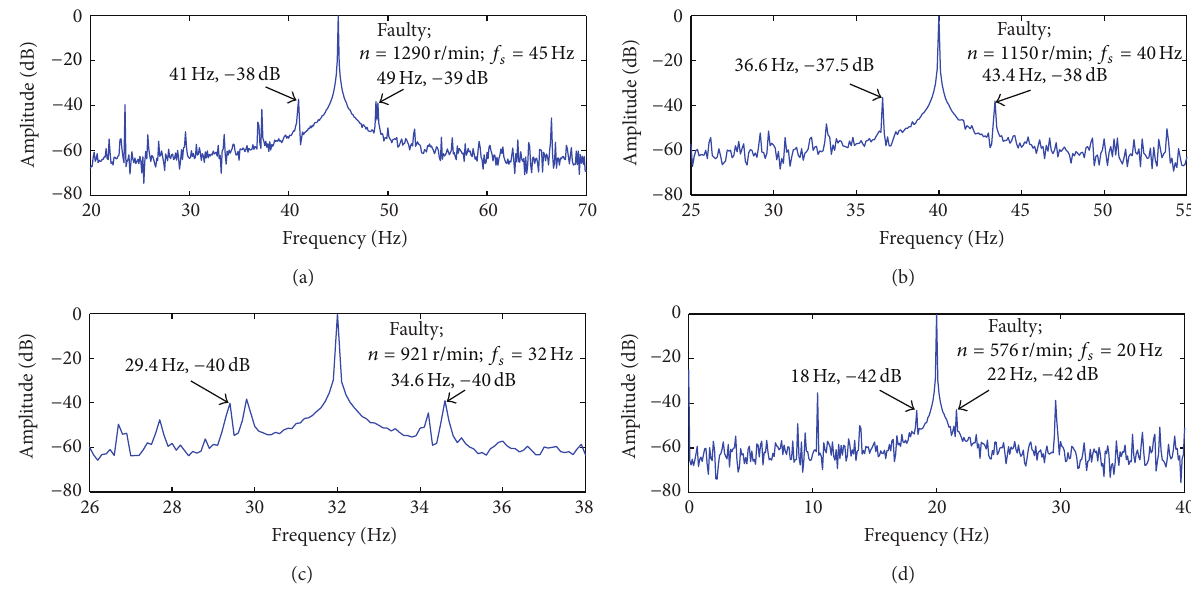
Figure 9: Power spectrum of the stator current around different excitation frequency of (a) 45 Hz, (b) 40Hz, (c) 32 Hz, and (d) 20 Hz.